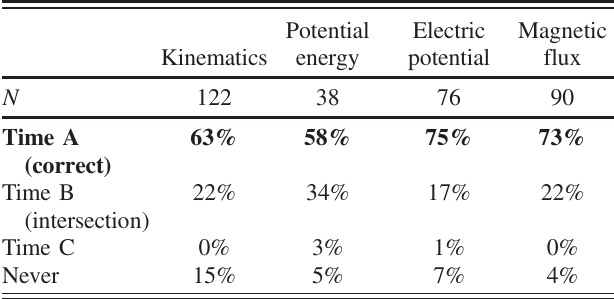
TABLE IV. Answer distribution data for the isomorphic graph tasks in chaining format (experiment 1B) for those students who answered both screening questions correctly. The task themselves are shown in the Appendix. (Data from magnetic flux graph task are drawn from the same year as the other three tasks). The correct answer choice is in boldface for